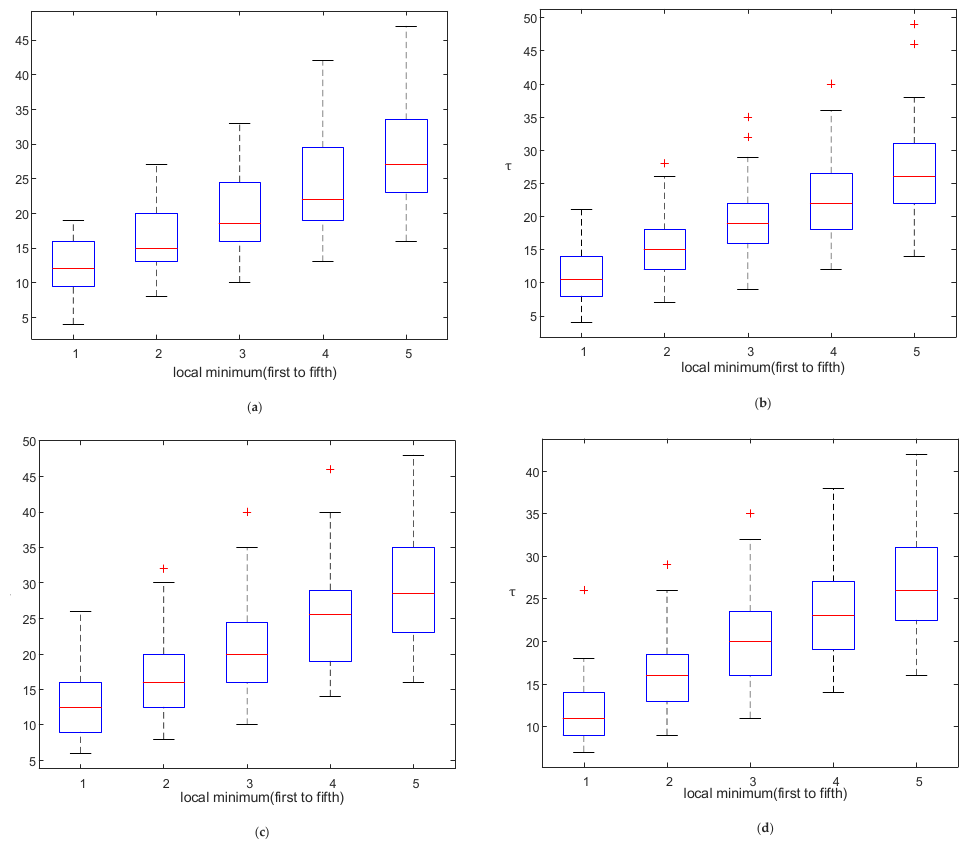
Figure 5. Box plots for four different split frame lengths. ( a ) 5s ‐ length split frame: the median of the first local minimum of the MI function is obtained as 12; ( b ) 8s ‐ length split frame: the median of the first local minimum is 10.5; ( c ) 10s ‐ length split frame: the median of the first local minimum is 12.5; ( d ) 15s ‐ length split frame: the median of the first local minimum is 11. And the “+” represents the outlier.